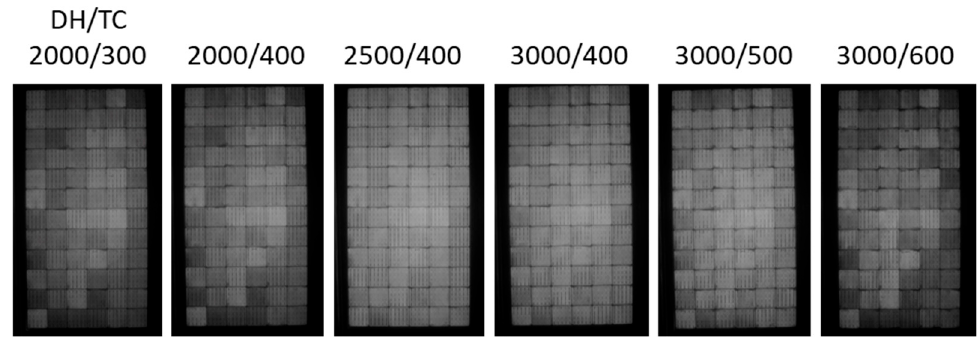
Figure 11. Electroluminescence images of module (B) with respect to combined DH-TC test se- quences.